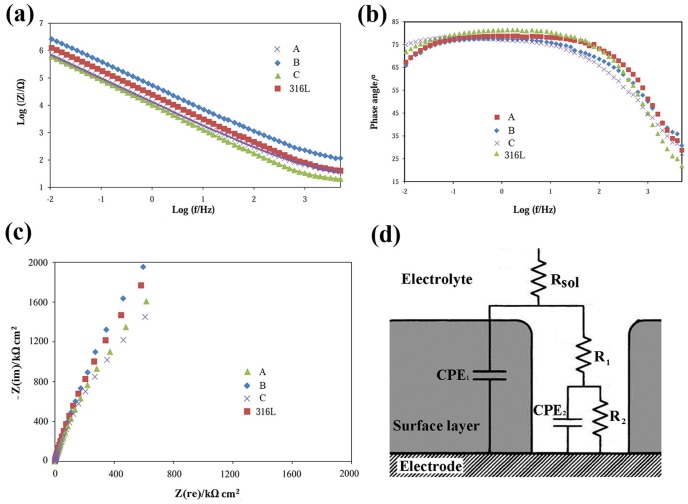
Bode impedance (a), Bode phase angle (b) and Nyquist (c) plots; and equivalent electrical circuit used for the quantitative analyses of the impedance spectra (d).